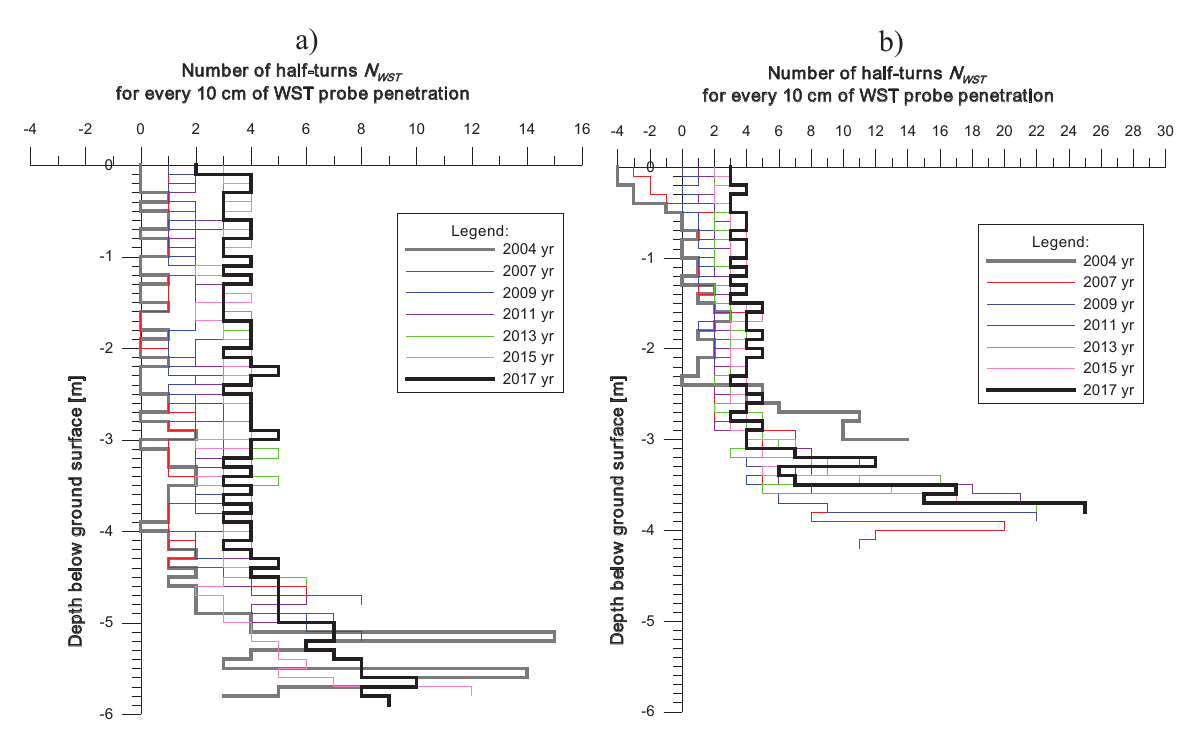
Fig. 6. WST probing results between counterforts P3 and P4 Figure 6 : WST probing results between counterforts P3 and P4: a) WST-5 and b)